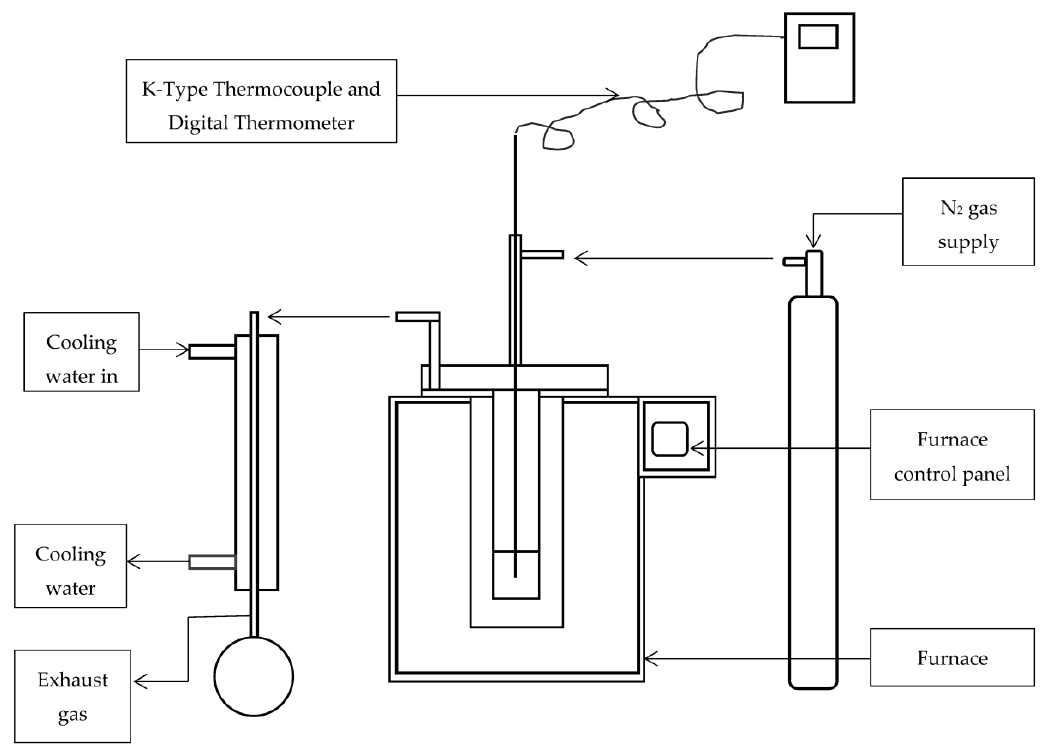
Figure 1. A schematic diagrammatic representation of the equipment used for torrefaction of bagasse. Reproduced with permission from [45].